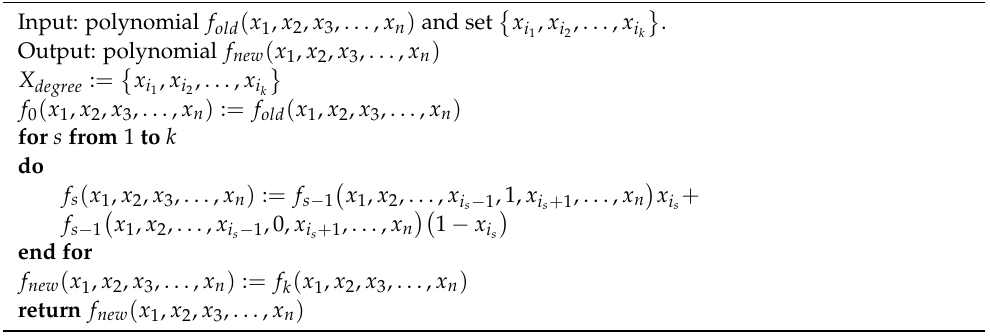
Algorithm 1 : Obtaining f new ( x 1 , x 2 , x 3 , . . . , x n ) from the polynomial f old ( x 1 , x 2 , x 3 , . . . , x n